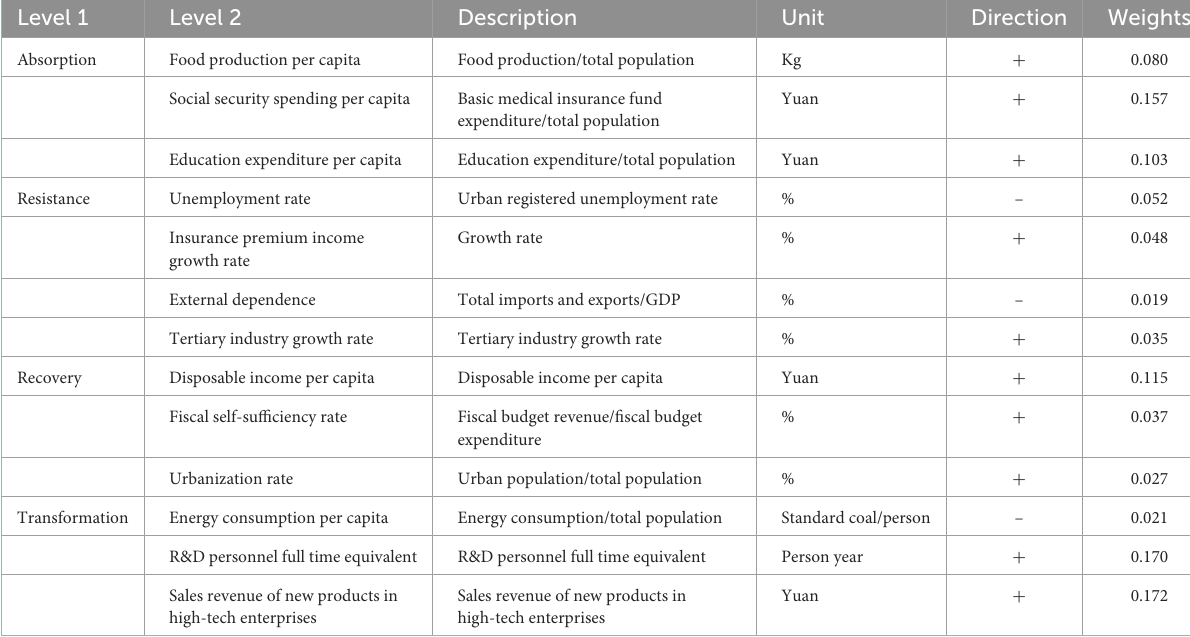
TABLE 2 Index system of economic